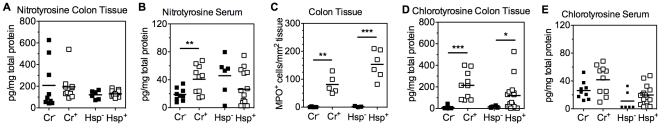
MPO-expressing cells in colon and level of protein adducts chlorotyrosine and nitrotyrosine in colon tissue and serum of both C. rodentium infected mice and Hsp+ TLR4−/− x IL-10−/− (DKO) mice.Nitrotyrosine levels in colon tissue (A) and serum (B) of uninfected (Cr−; n = 10 for tissue, n = 9 for serum) C57BL/6J mice, C. rodentium infected (Cr+; n = 10) C57BL/6J mice at 14 DPI, Helicobacter-negative (Hsp−; n = 6) DKO mice and Helicobacter-positive (Hsp+; n = 15) DKO mice at 20–35 weeks of age. (C) MPO+ cells in colon tissue of Cr−, Cr+, Hsp−, and Hsp+ (n = 5 per group) were counted in ten high power (40×) fields of colon tissue per mouse and averaged. Chlorotyrosine levels in colon tissue (D) and serum (E) from Cr− (n  = 10 for tissue, n = 9 for serum), Cr+ (n = 10), Hsp− DKO (n = 6) and Hsp+ DKO (n = 15). Adduct concentrations (A, B, D, E) were normalized to total protein in each sample. Line indicates mean value. * P<0.05, ** P<0.01, *** P<0.001 by unpaired Student's t-test.